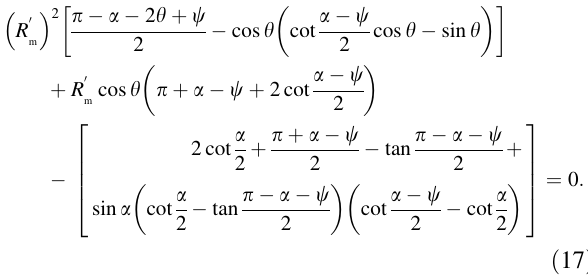
, as a function of the angle, w , R